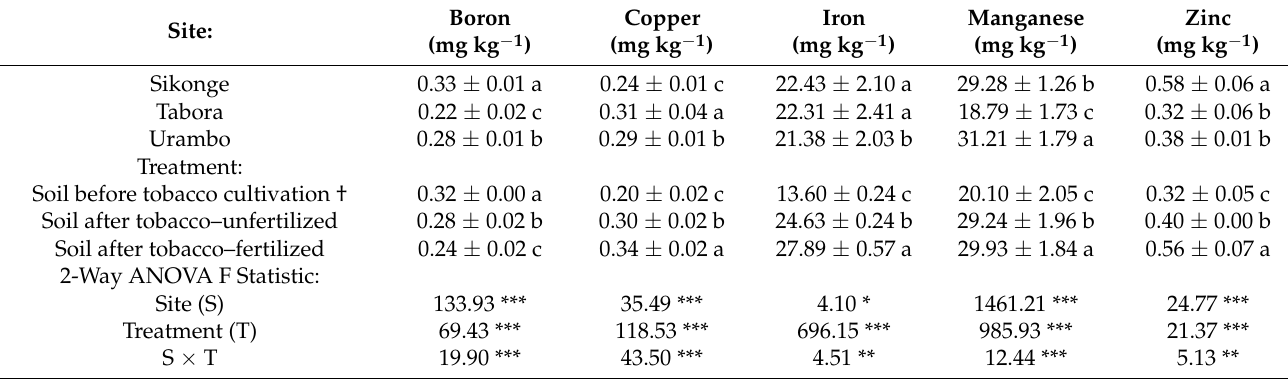
Table 1. Selected soil properties of the Sikonge, Tabora and Urambo experimental sites as affected by tobacco cultivation. Boron Site: (mg kg − 1 )